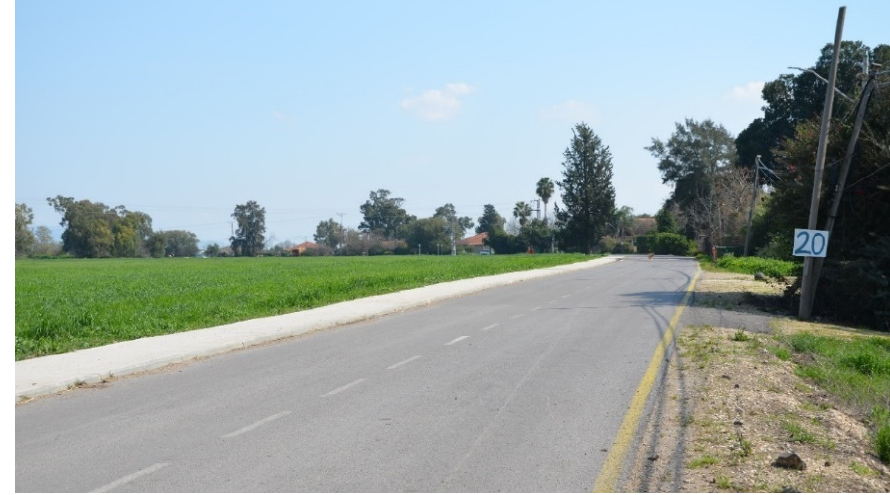
Figure 7. Excessive distances at Moshav HaYogev. Photo by the authors.